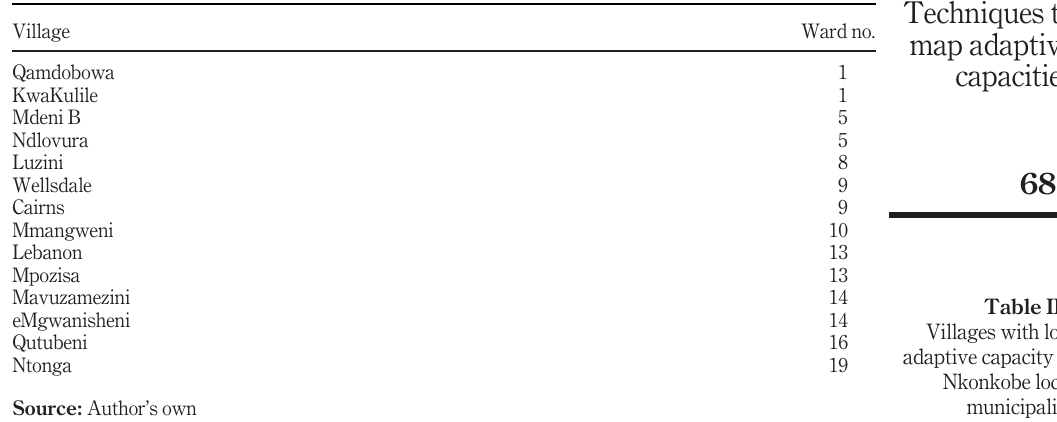
Table III. Villages with